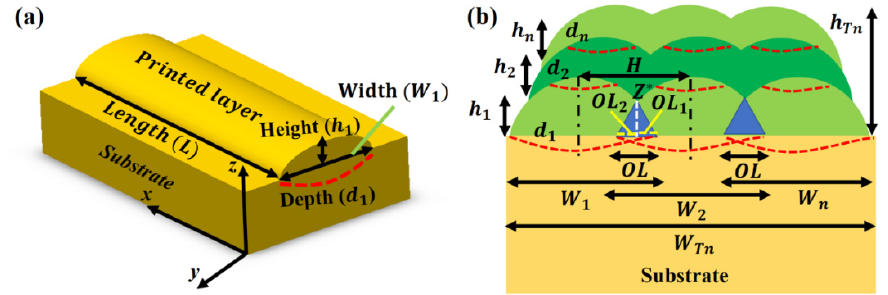
Figure 2. Schematic of laser powder bed fusion printing in the case of the ( a ) single ‐ layer and ( b ) multi ‐ layers.